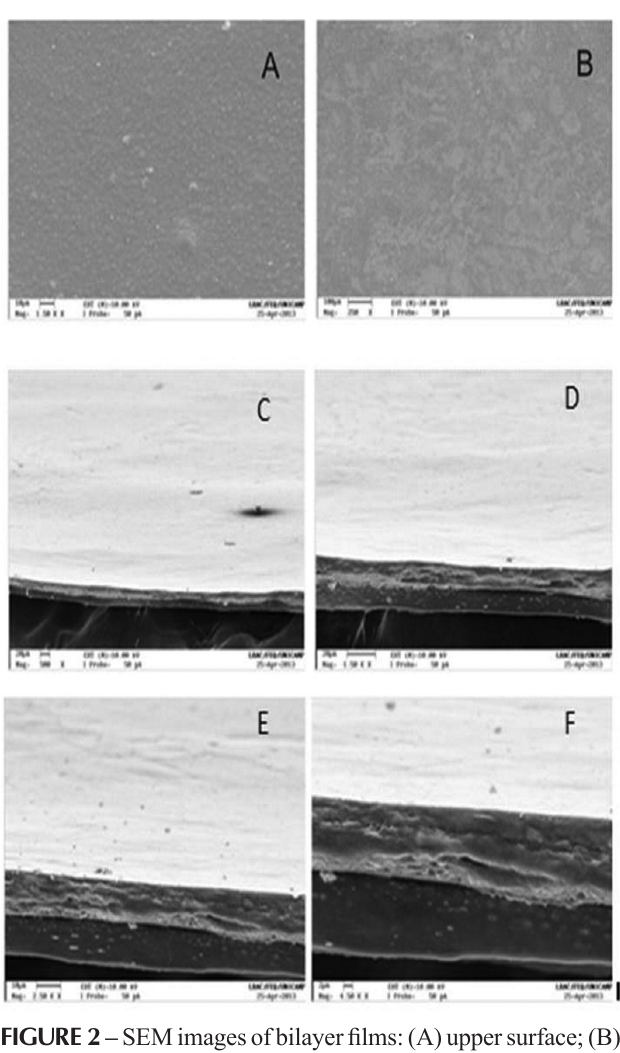
FIGURE 2 – SEM images of bilayer films: (A) upper surface; (B) lower surface; (C-F) cross-sections, at different magnifications.